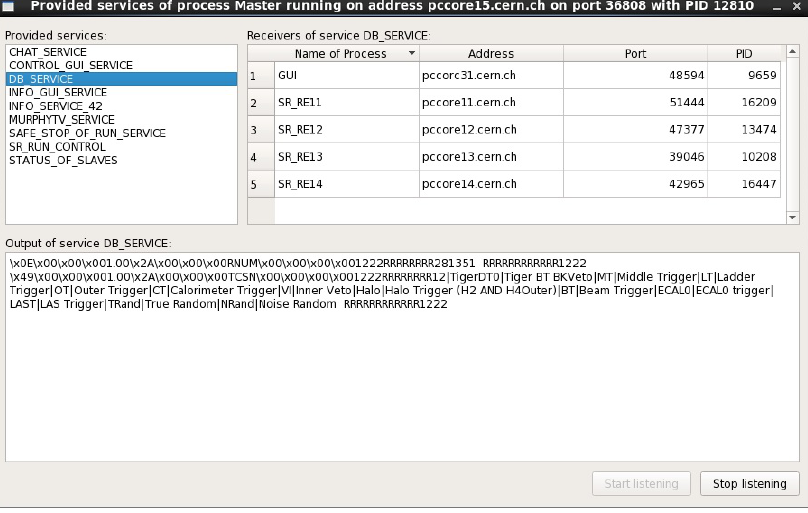
Figure 3. The provided services widget of the DIALOG